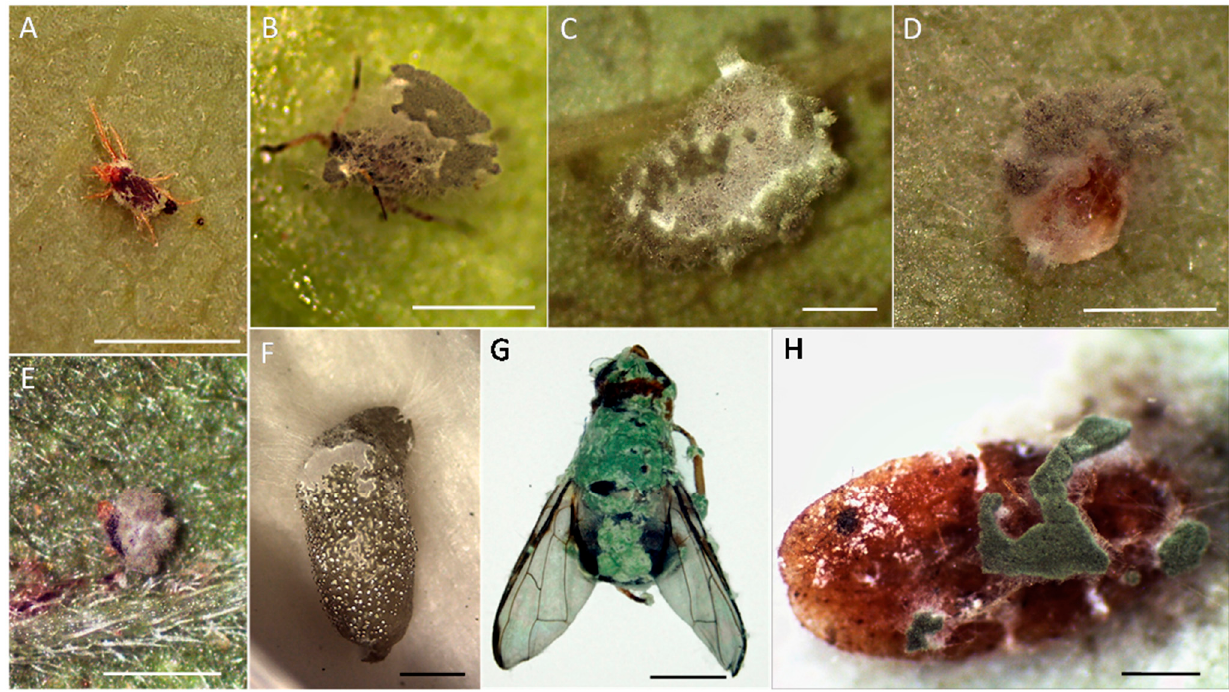
Figure 8. Abundant conidiation and mycelial formation of Metarhizium sp. BCC 4849 on various insect cadavers. ( A ) Cassava mite, Tetranychus truncates . ( B ) Bean aphid, Aphis craccivora . ( C ) Cassava mealybug, Phenacoccus manihoti . ( D ) Tobacco whitefly, Bemisia tabaci . ( E ) African mite, Eutetranychys africanus . ( F ) Sweet potato weevil larvae, Cylas formicarius . ( G ) Oriental fruit fly adult, Bactrocera dorsalis . ( H ) tapioca scale, Aonidomytilus albus . ( A – E ) Bars, 0.5 mm. ( F – H ) Bars, 2.0